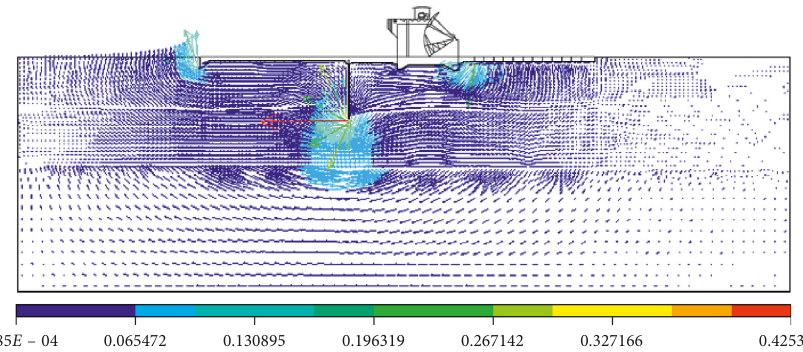
Figure 25: Seepage gradients in 1# sluice foundation in dry